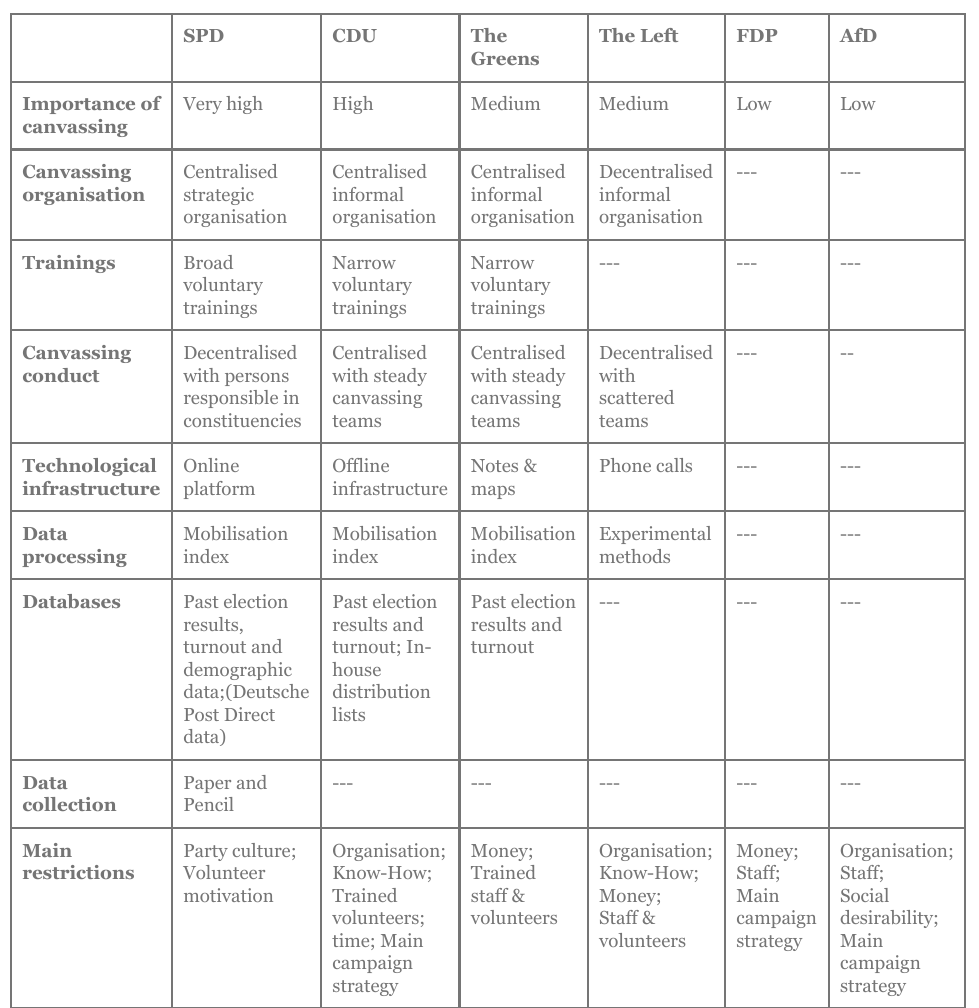
Table 3: Main characteristics of data-driven canvassing in the 2016 elections in